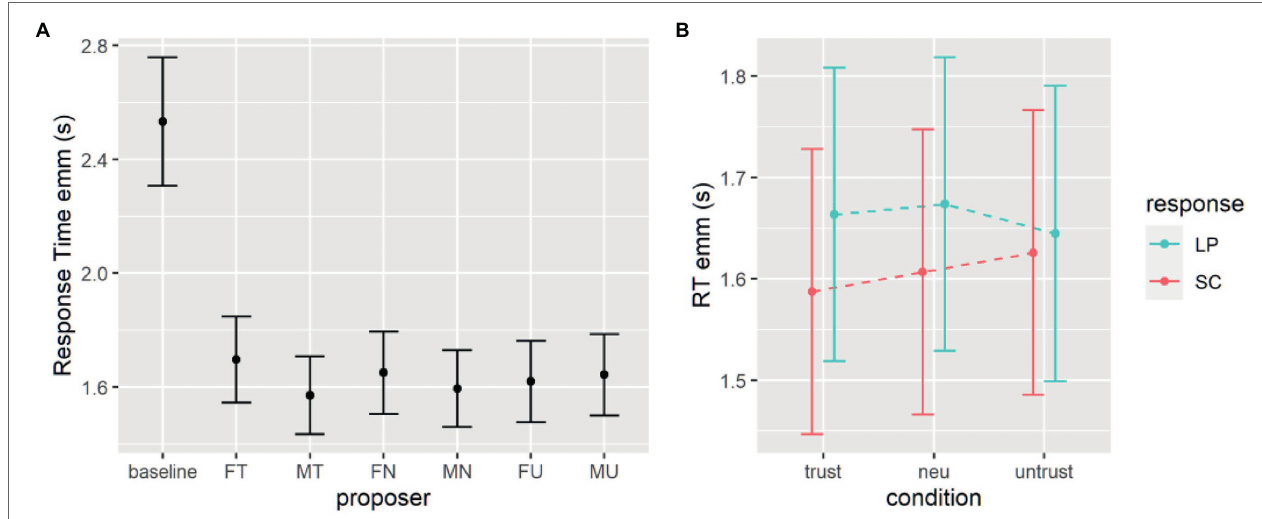
FIGURE 7 | Estimates for response times in the probability discounting task. (A) Estimates from the first model, where the baseline is the condition with the highest RTs. (B) Estimates from the second model, without the baseline data. SC, small certain option; LP, later probabilistic